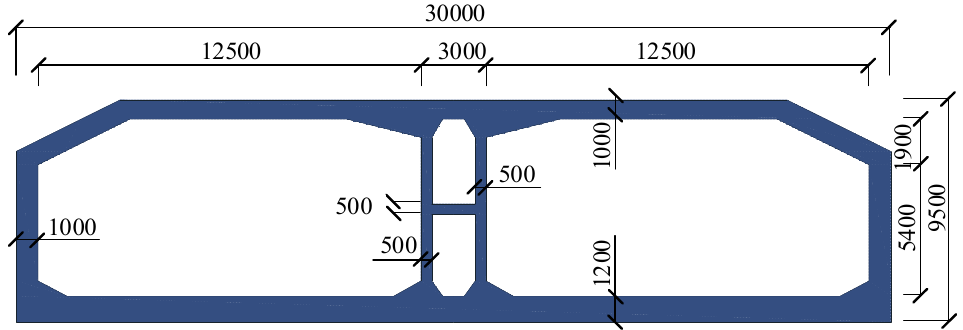
Table 1. The soil parameters for the present study. shear modulus ( G )